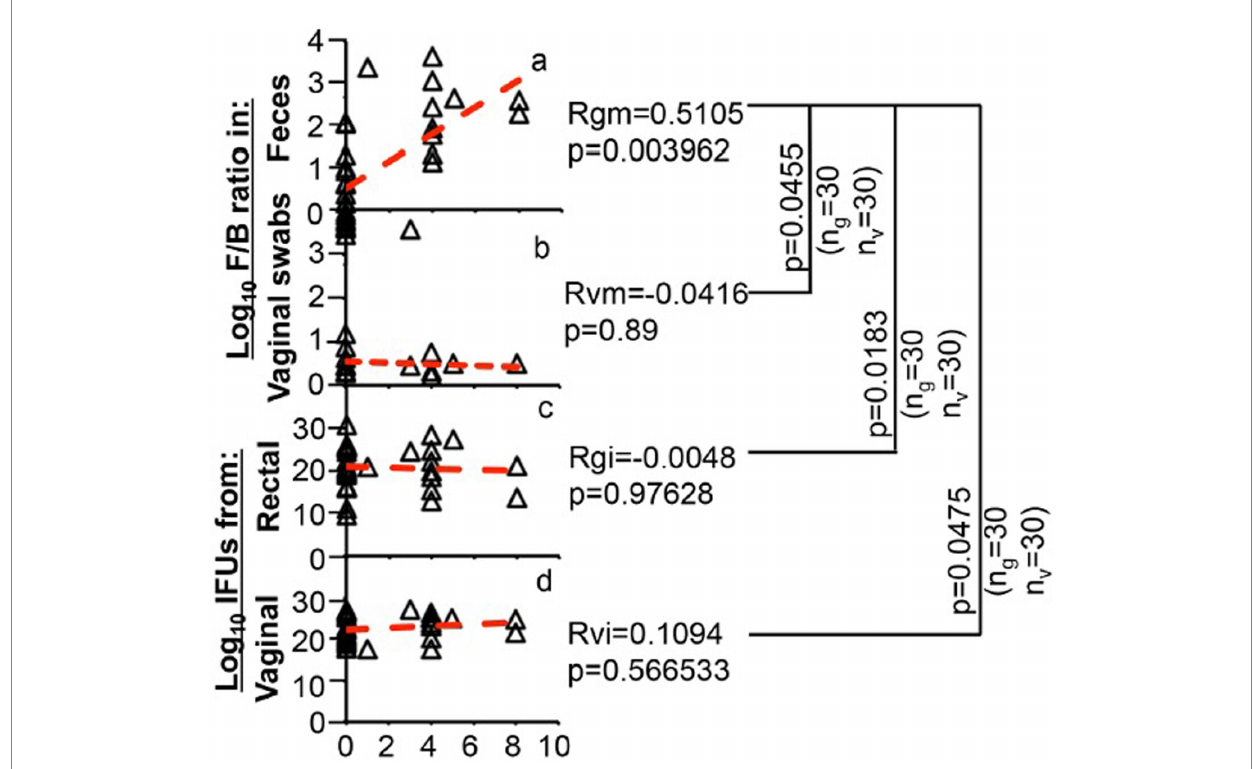
FIGURE 8 Correlation of oral antibiotics-enhanced hydrosalpinx with fecal microbiota but not vaginal microbiota or C. muridarum shedding from either genital or gastrointestinal tract. The hydrosalpinx score from each DBA2/J mouse as described in Figure 1 legend ( X -axis) was used to correlate with microbiota profile expressed as Log10 F/B ratios obtained from feces (Y-axis, panel a) or vaginal swabs ( Y -axis, b) or live organism shedding expressed as Log10 IFUs (total IFU from swabs collected from a given mouse over time, Y -axis) from rectal (c) or vaginal (d) swabs using the Spearman’s correlation formula as described in the materials and method section. The total IFU from each mouse was obtained by adding IFUs from all time points observed. The correlation co-efficient between the hydrosalpinx scores and gut (or feces) F/B ratios was defined as Rgm, which is 0.5105 with a p value of 0.0039, the correlation co-efficient between the hydrosalpinx scores and vaginal F/B ratios was Rvm = − 0.0416 with a p = 0.89 (two tails), or rectal IFUs (Rgi = 0.0048, p = 0.9763) or vaginal IFUs (Rvi = 0.1094, p = 0.5665). A positive correlation was only identified between the hydrosalpinx